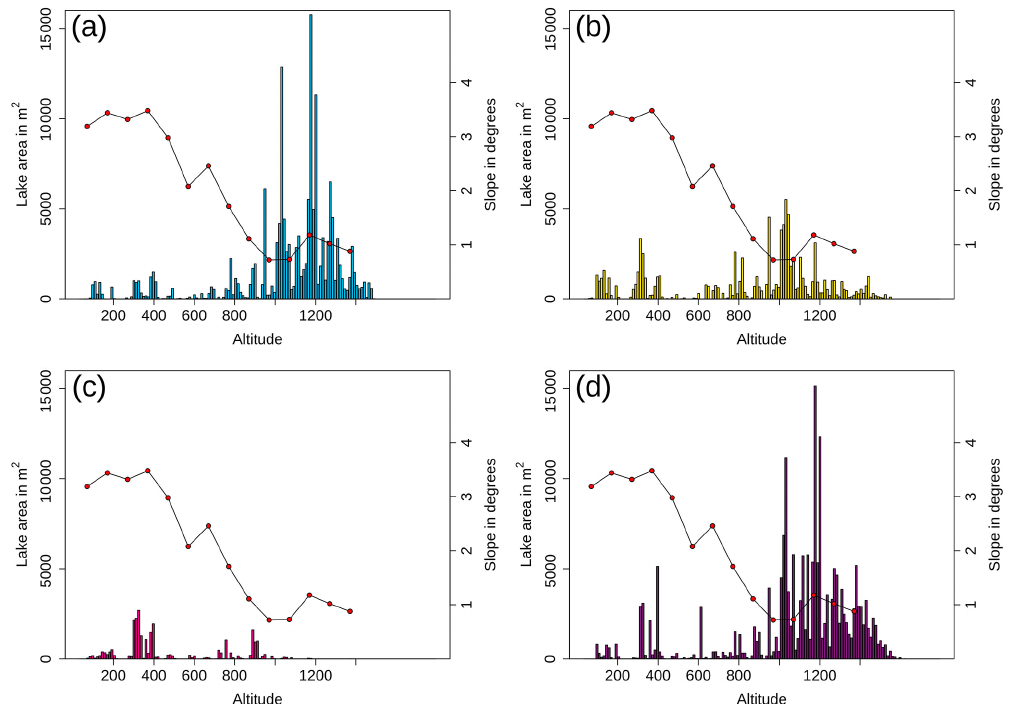
Figure 4. Altitude distribution of lake area for the maxima of 2016 (a) , 2017 (b) , 2018 (c) , and 2019 (d) per 10m altitude difference. Red dots show average slope angle for 100m altitude bins.